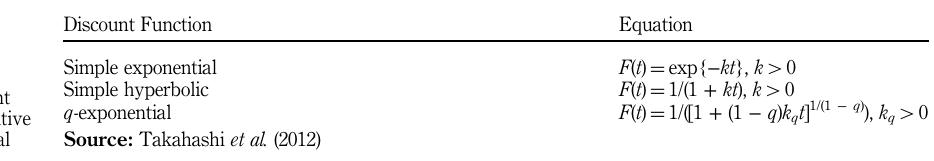
Table III. Different discount functions alternative to the